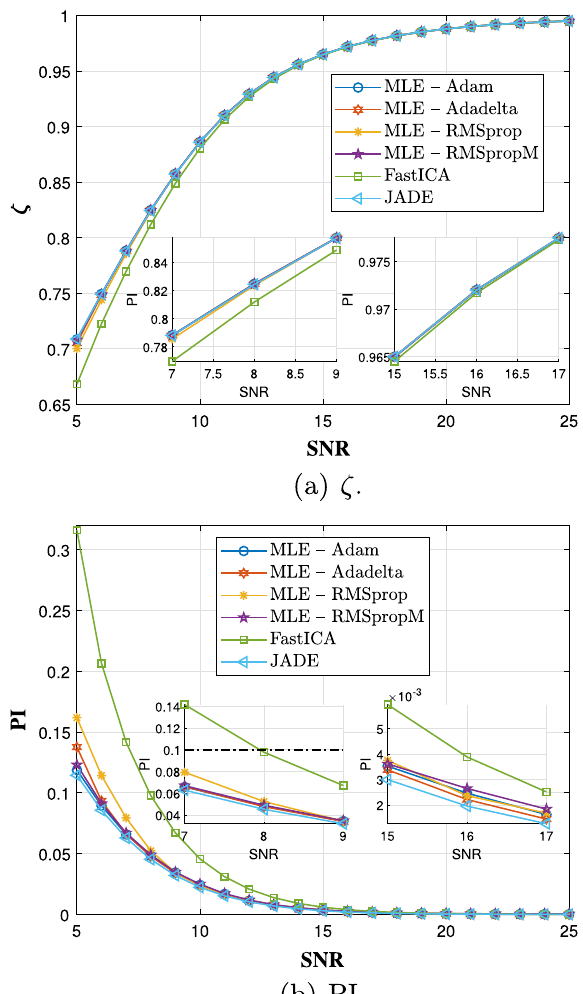
Fig. 6 The separation performance changing trend with SNR and compared with FastICA and JADE in the form of ζ and